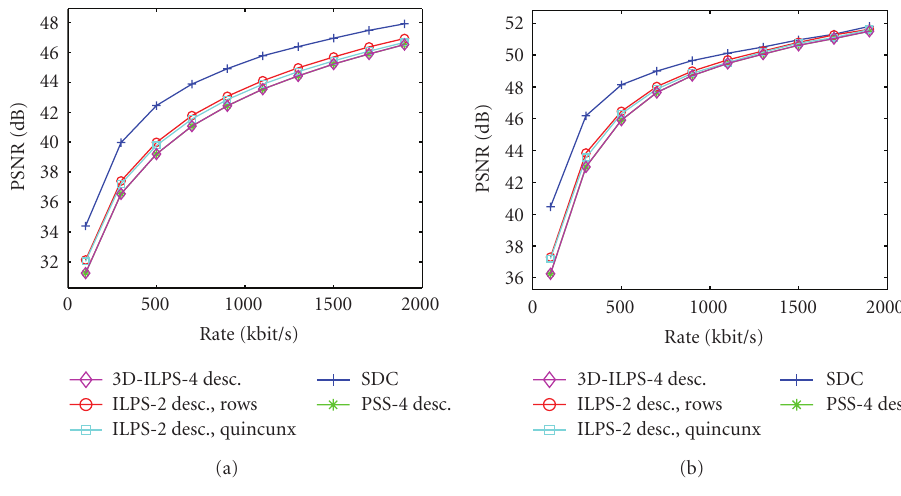
Figure 10: Performance of color view, all subsequences received. (a) Breakdance. (b) Ballet.